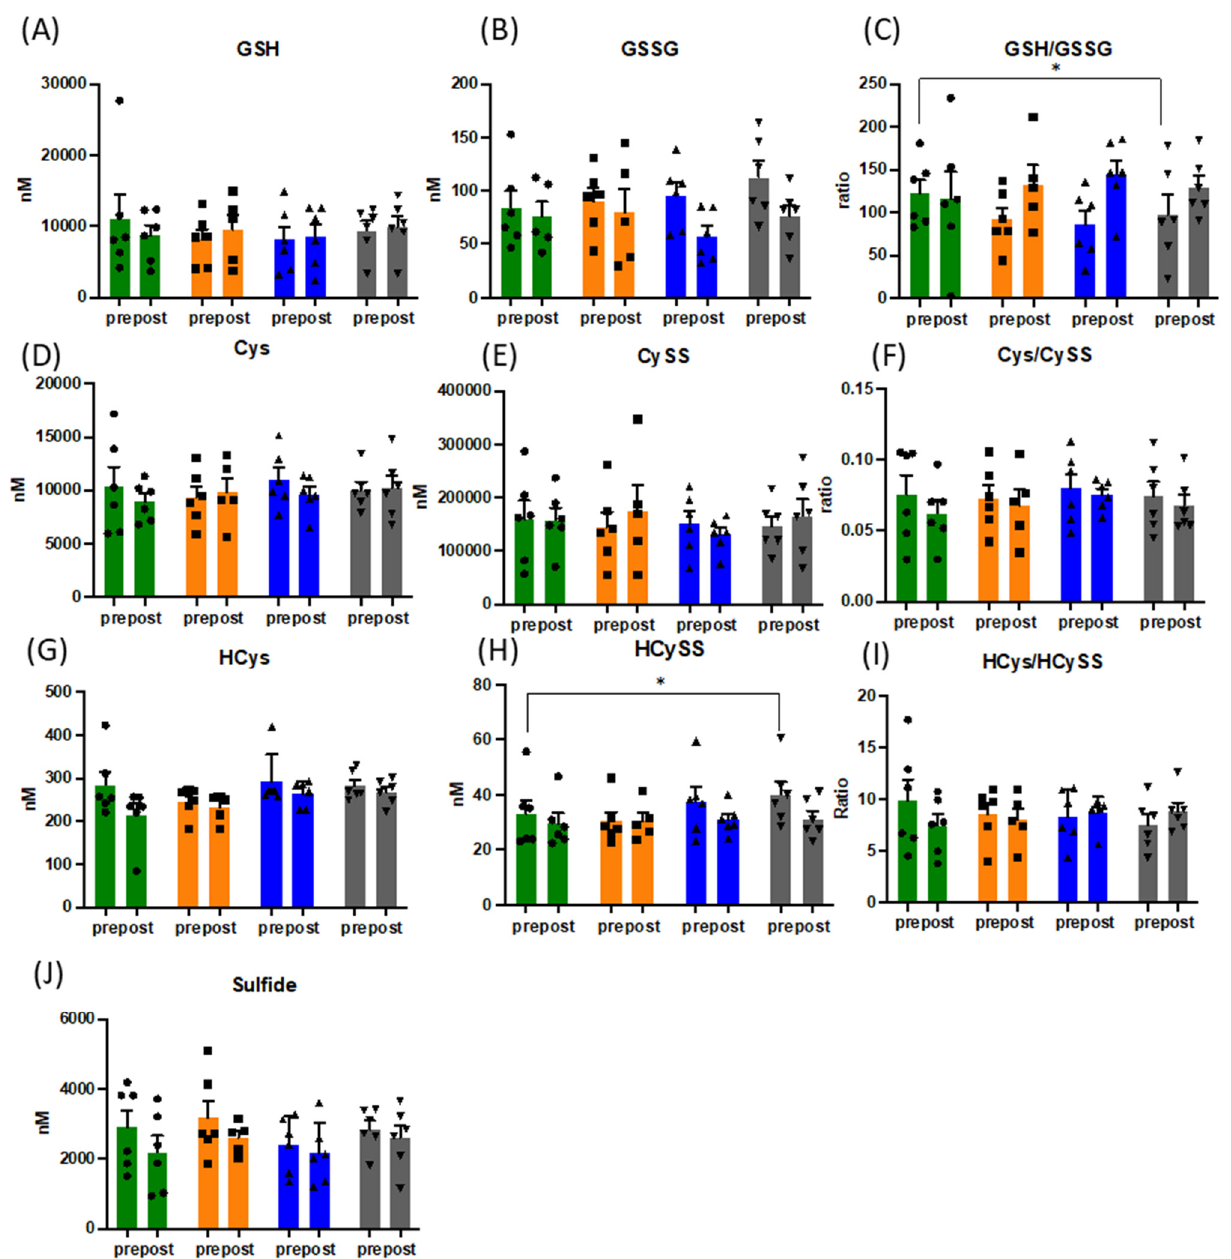
Figure 1. Changes in pattern of responses of the free thiol metabolome ( A – J ). Data presented for n = 6 before and after acute physiological challenge of a cardiopulmonary exercise test, presented as mean and SEM, with overlaid individual data (circles, squares, up- and downward triangles). Data presented in nM or concentration ratio. Green bars = baseline, orange bars = week 3, blue bars = week 6 and grey bars = week 12. Abbreviations: GSH: reduced gluthathione; GSSG: oxidised glutathione; Cys: cysteine, CySS: cystine; HCys: homocysteine, HCySS: homocystine, * = p < 0.05.